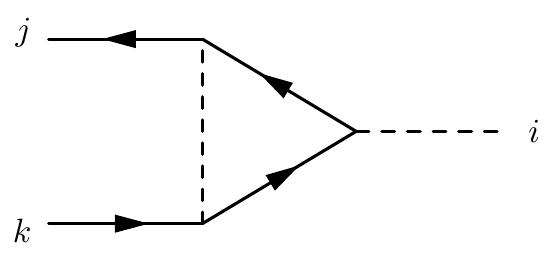
Figure 4 . One loop corrections to